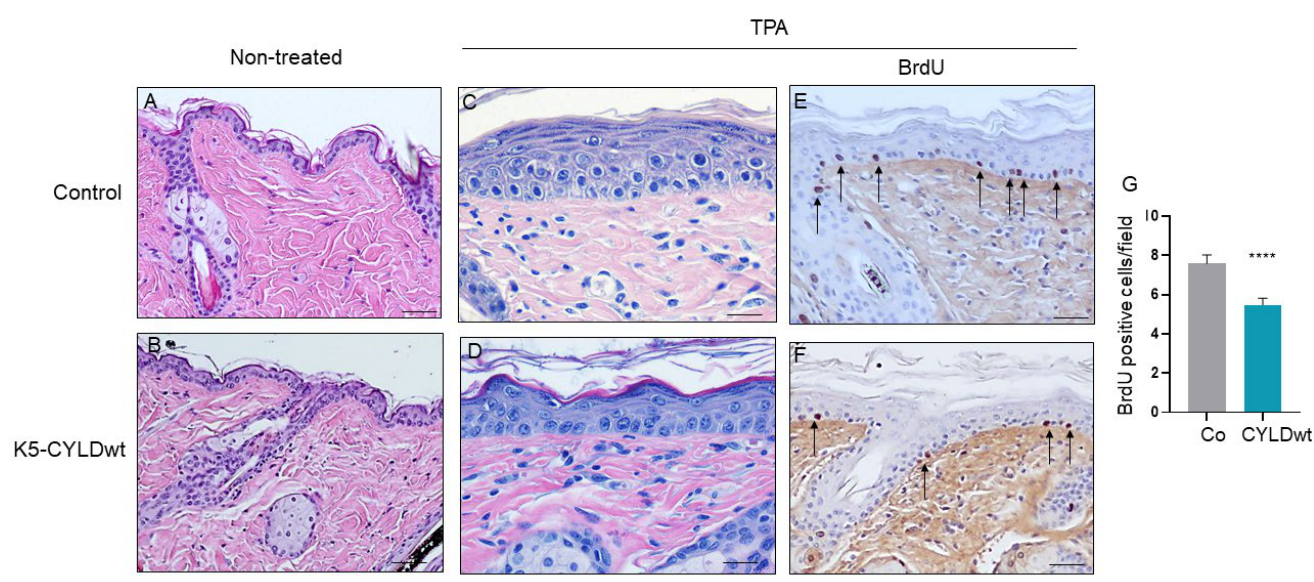
Figure 4. Diminished epidermal hyperplasia in the skin of K5-CYLDwt mice subjected to TPA treatment. ( A – D ) Repre- sentative back skin sections from Control ( A , C ) and K5-CYLDwt ( B , D ) mice stained with hematoxylin and eosin (H&E). ( A , B ) Untreated skins. The vehicle (acetone) was applied for 3 weeks in the back skin of mice, and no relevant differences were found between the histology of the back skin of Control ( A ) and transgenic ( B ) mice. ( C , D ) Hyperplastic epidermis induced by topical application of TPA. Observe the modest increase in the number of epidermal layers that TPA elicits in the skin of transgenic mice ( D ). ( E , F ) Representative images showing BrdU incorporation in the skins of Control ( E ) and K5-CYLDwt ( F ) mice treated with TPA. Note the lower number of BrdU-positive cells per field detected in the epidermis of transgenic mice. ( G ) Graphical representation of the number of BrdU-positive cells per field in the back skin of mice of both genotypes. Data are shown as mean ± SEM **** p < 0.0001 by two-tailed Mann–Whitney test. Scale bars : 50 µm ( A , B ); 20 µm ( C – D ); 30 µm ( E – F ).